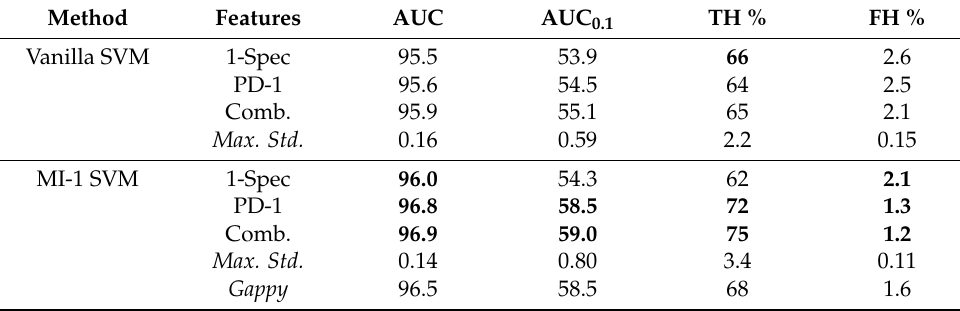
Table 3. Comparison of Results for Vanilla SVM and MI-1